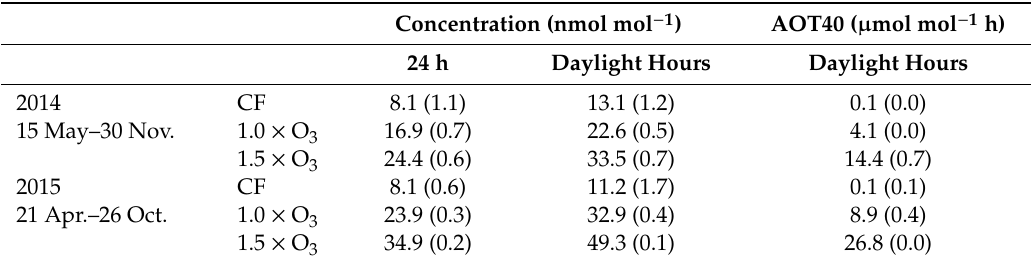
Table 1. Average concentration and accumulated exposure over a threshold of 40 nmol mol − 1 (AOT40) [40] of ozone in each gas treatment during the period of ozone